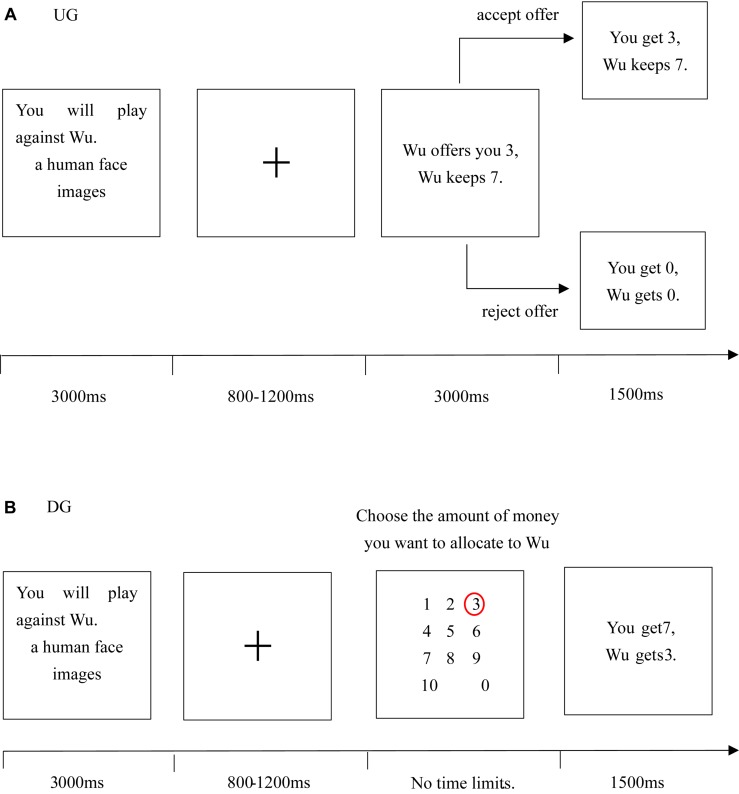
Schematic structure of behavioral experimental paradigm. The behavioral experimental paradigm consists of two stages: adapted UG (A) and DG (B).